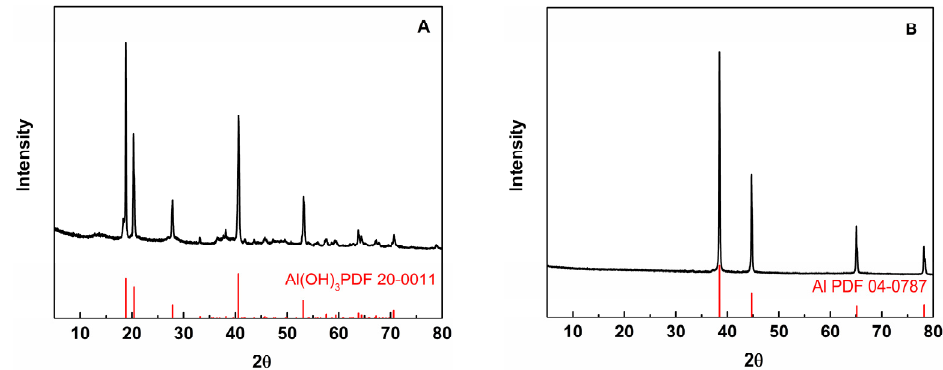
Figure 2. Investigation of oxidation of Al NPs dispersed in aqueous solution at room temperature. ( A ) XRD of Al NPs dispersed in ultrapure water. ( B ) XRD of Al NPs dispersed in phosphate buffer (PBS, 0.01 M, pH 7.0).